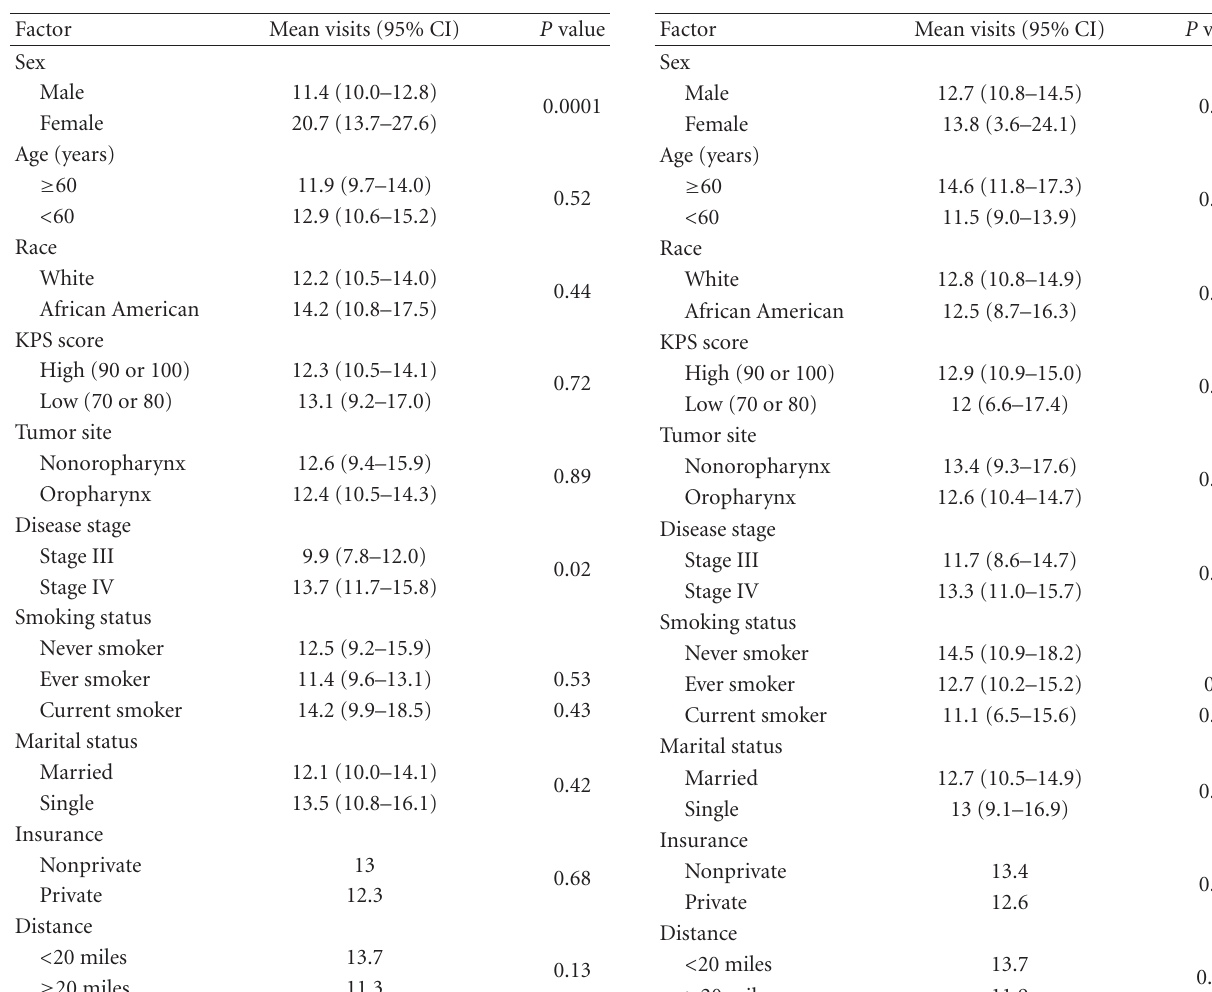
Table 3: Nursing visits: simple linear regression model. Table 4: Dietician services: simple linear regression